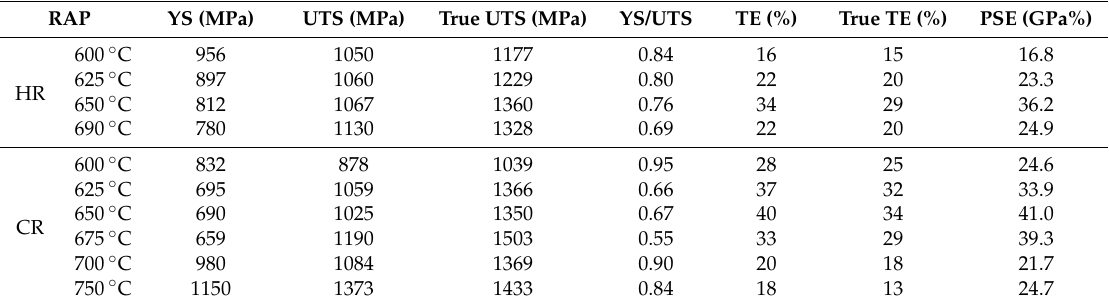
Table 1. Mechanical properties of the experimental